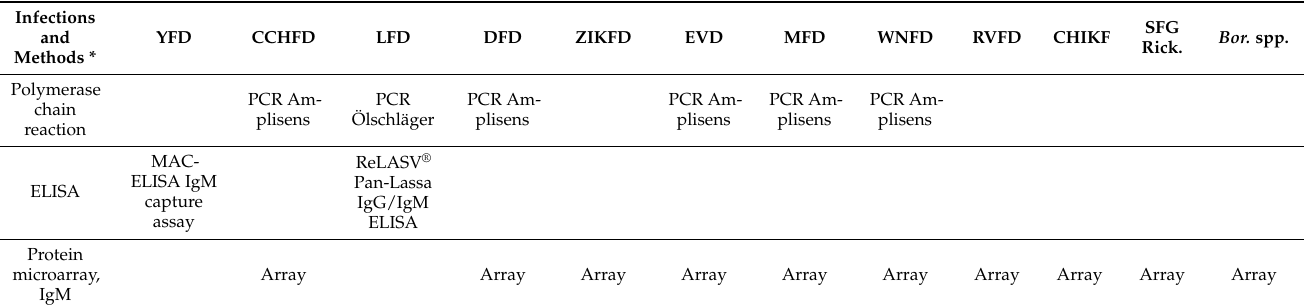
Table 1. Methods used to diagnose infectious